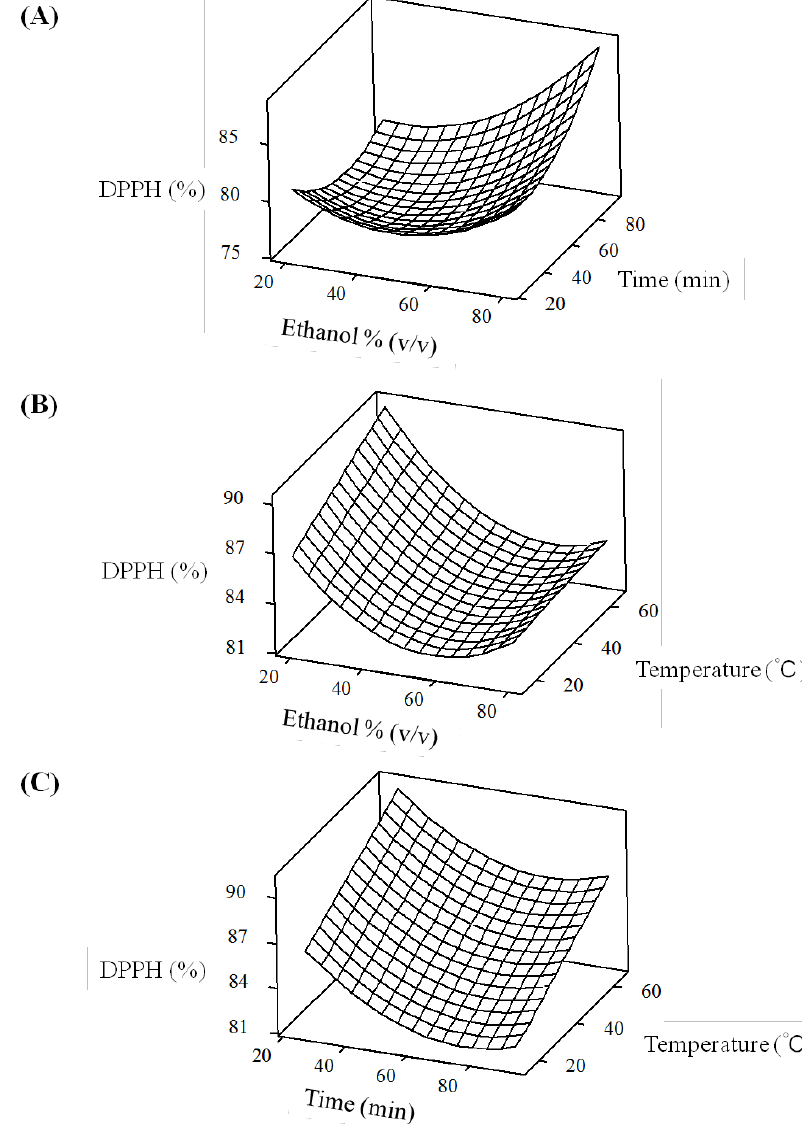
Figure 1. Response surface plots for the effects of ethanol concentration, extraction time and temperature on antioxidant activity of green tea extracts. ( A ) Ethanol concentration and extraction time; ( B ) ethanol concentration and extraction temperature; ( C ) extraction time and